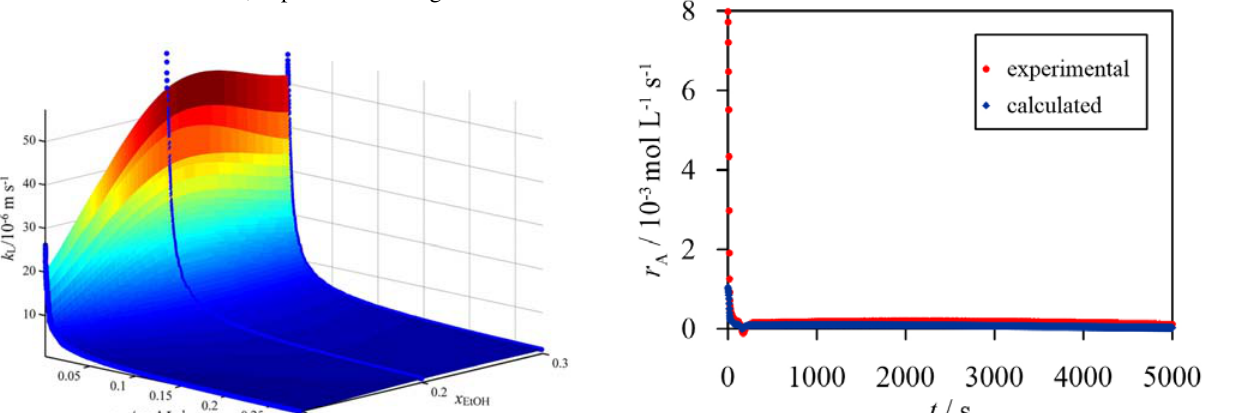
Figure 3. Surface plot of mass transfer coefficients, k tion of sodium hydroxide concentration in the bulk liquid and mole fraction of ethanol, at the temperature, ϑ = 30 °C.